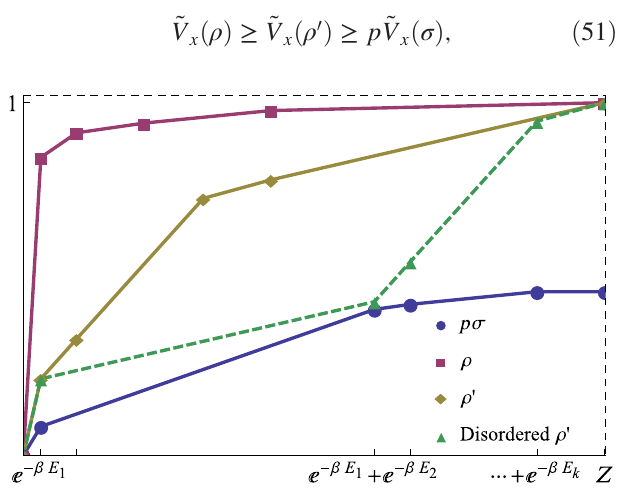
FIG. 6. Here, we show graphically the steps of the proof of the first part of Theorem 5. In the decomposition of Eq. (44) the curve p σ must always be below that of ρ 0 and, hence, also ρ . This sets the maximum probability p (cid:3) as defined in Eq. (45). Both p σ and the disordered ρ 0 have the same β